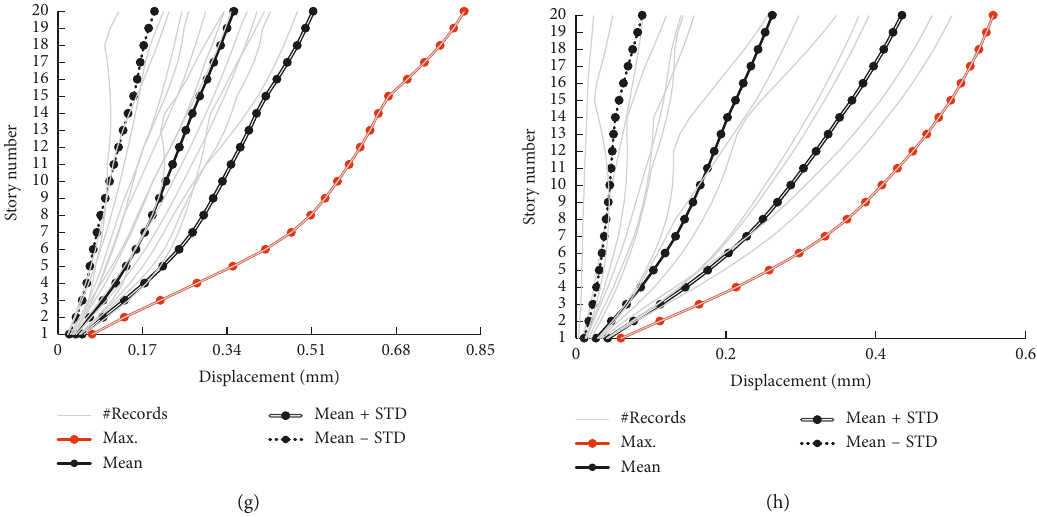
Figure 8: Maximum displacement in 3-, 5-, 8-, and 20-story building subjected to near- (a, c, e, g) and far-field (b, d, f, h) earthquakes.